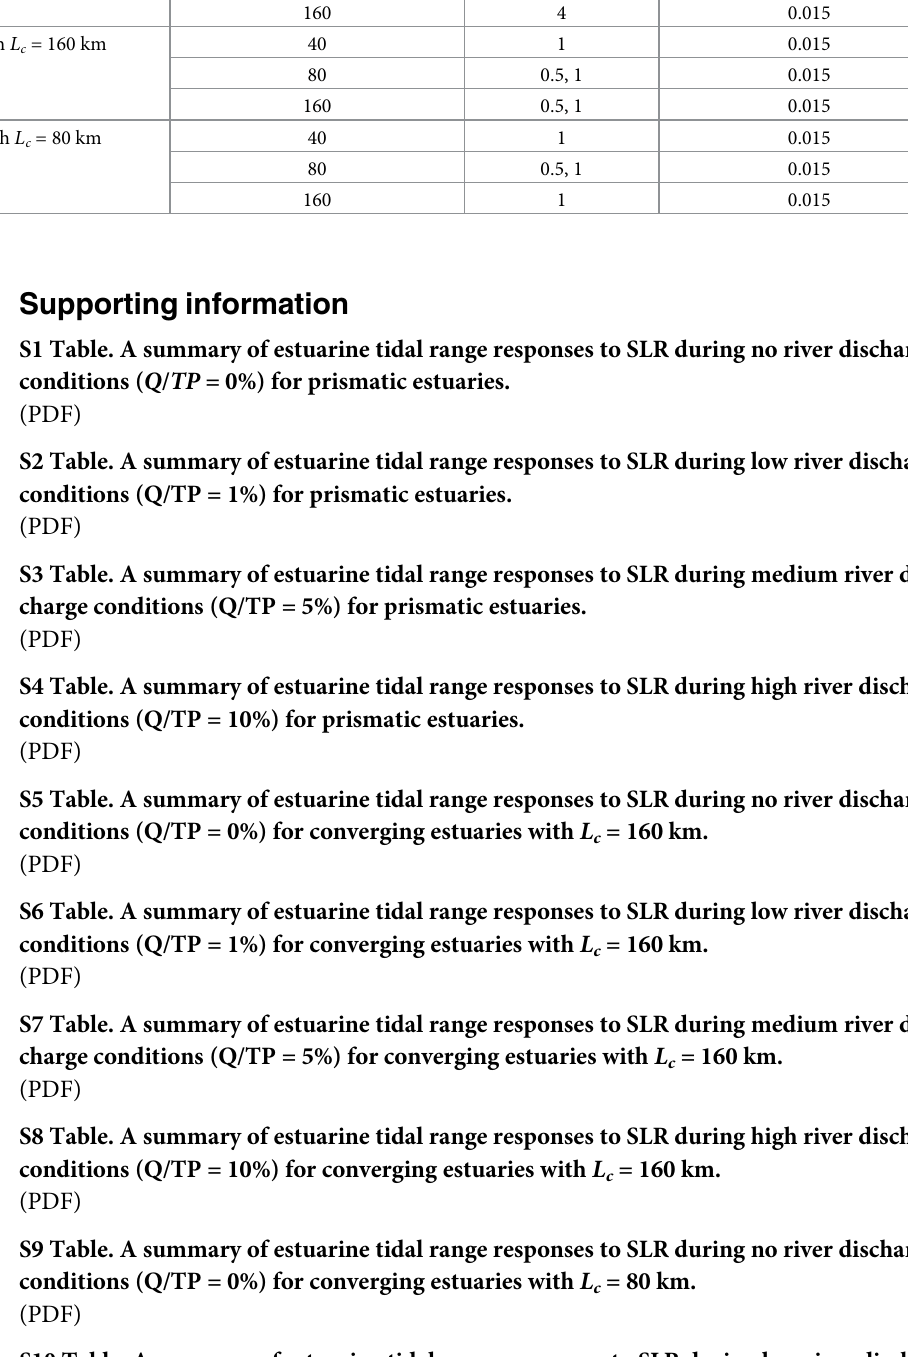
S10 Table. A summary of estuarine tidal range responses to SLR during low river